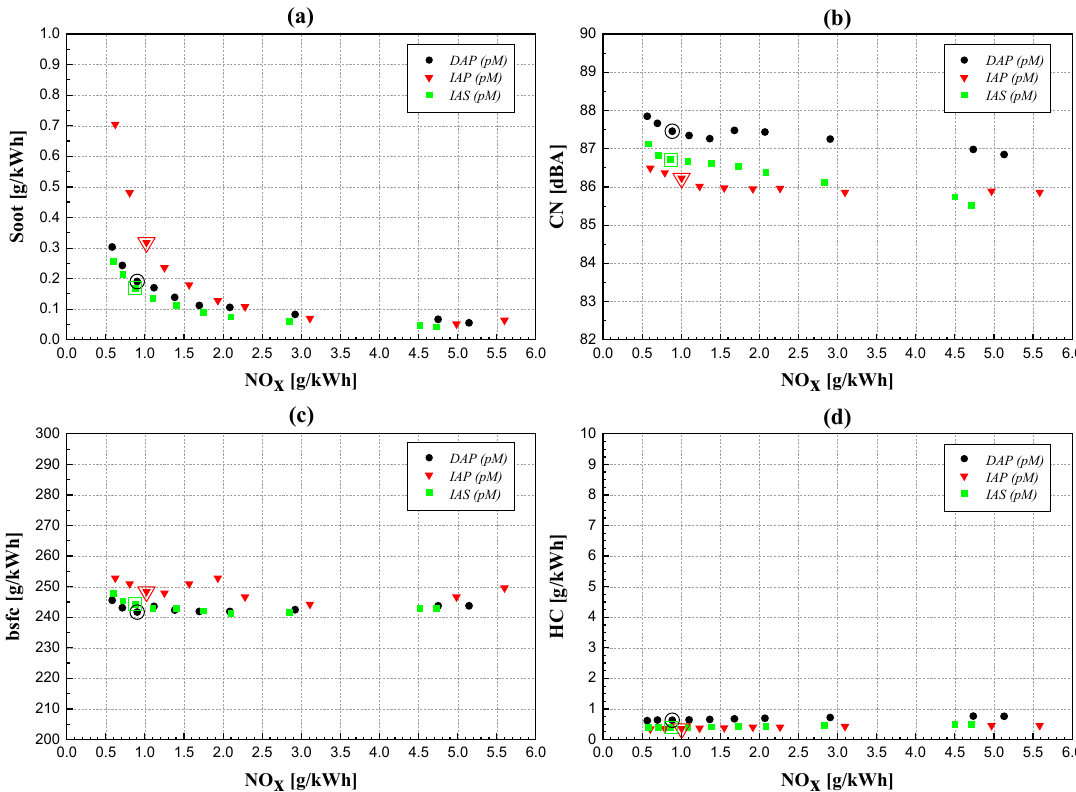
Figure 8. Engine-out soot emissions ( a ) CN; ( b ) bsfc ; ( c ) and engine-out HC emissions; ( d ) vs. NO x for the three injector typologies, at 2000 × 5.